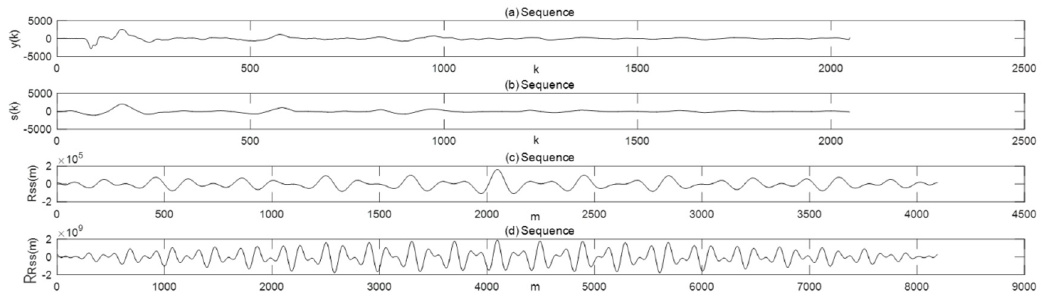
Figure 4. Signal denoising and enhancement . ( a ) Original sequence waveform, ( b ) waveform after wavelet denosing, ( c ) waveform after first self-correlation, ( d ) waveform after quadratic self-correlation.